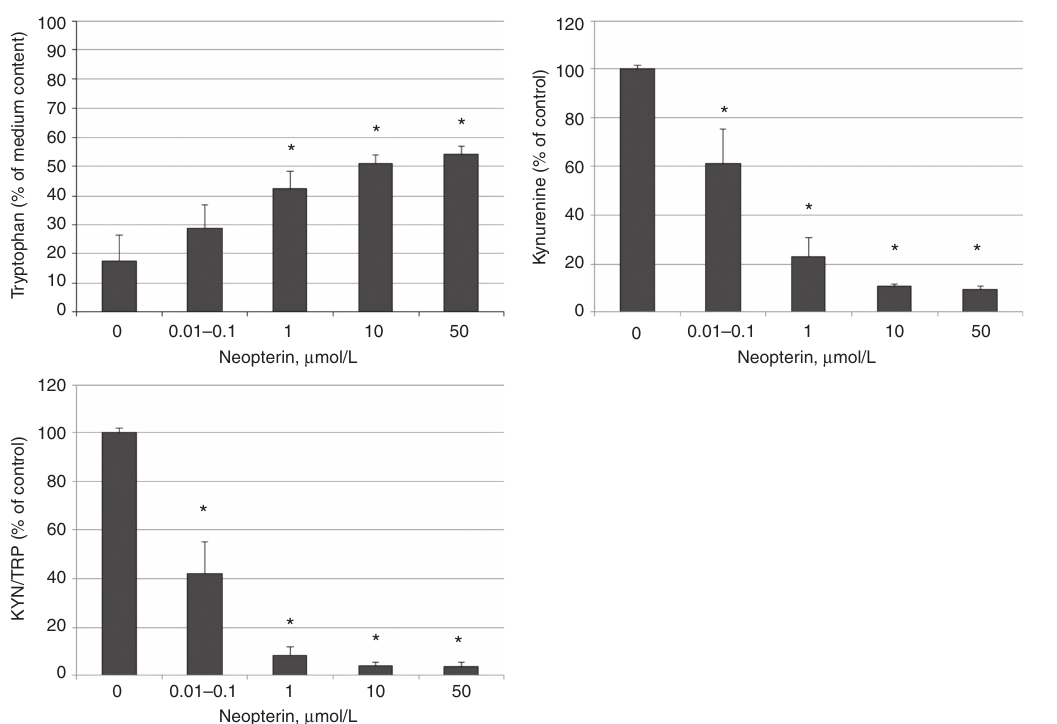
Figure 2 Concentrations of tryptophan (upper left), kynurenine (upper right), and the kynurenine-to-tryptophan ratio (KYN/TRP) in the supernatants collected from peripheral blood mononuclear cells after exposure to increasing concentrations of neopterin and stimulation with mitogen phytohemagglutinin for 48 h. Columns are representative for three independent experiments with cells obtained from three different donors and run in duplicates. Results are expressed as % of baseline (or as % of initial medium content for tryptophan), and columns show mean ± standard error of the mean; *p <